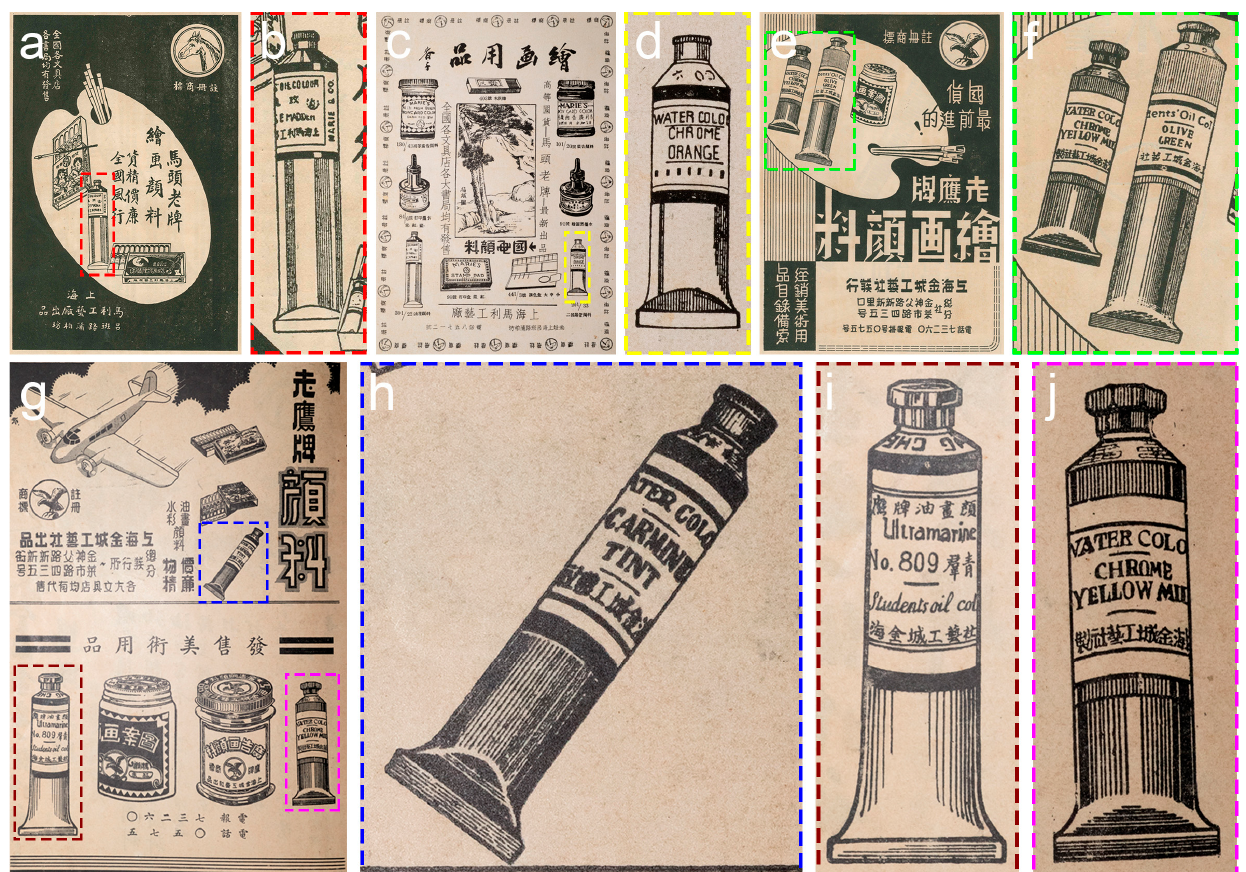
Figure 5. Advertisements by Marie from 1935 ( a ), 1937 ( c ) and by Eagle from 1936 ( e , g ) with highlighted paint tubes (colour rectangles) and corresponding details showing types of paints ( b , d , f , h , i , j